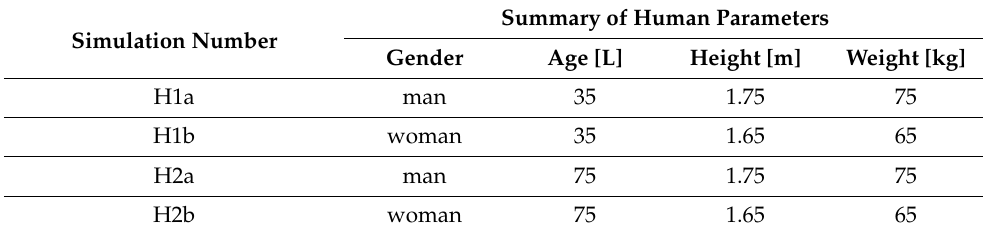
Figure 3. Graphical overview of simulations. Table 5. Table summarizing the human parameters used in